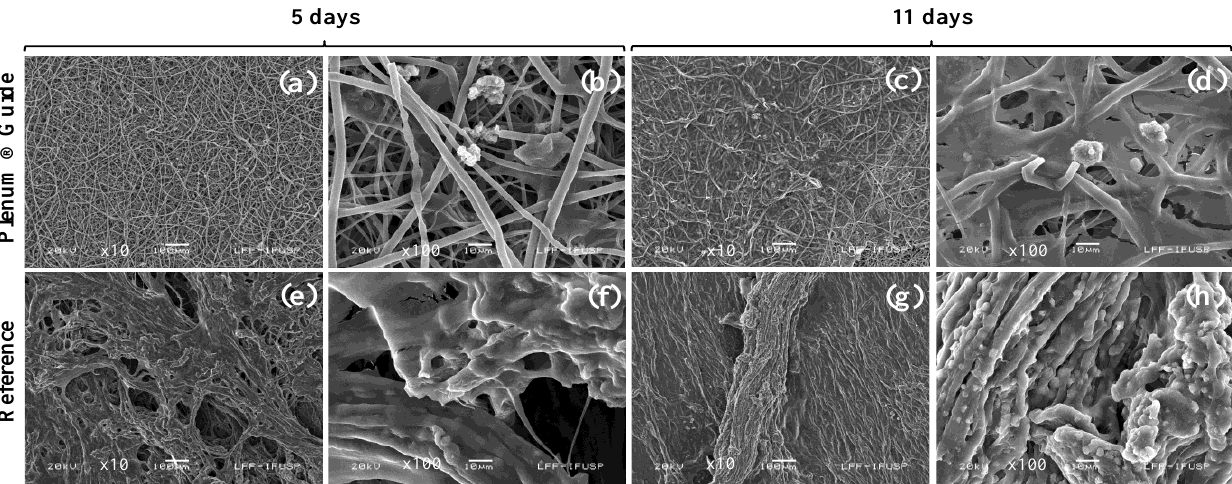
Figure 5. Osteogenic differentiation on the PDO membrane after incubation for ( a , b ) 5 and ( c , d ) 11 days. Osteogenic differentiation on the collagen membrane after incubation for ( e , f ) 5 and ( g , h ) 11 days.